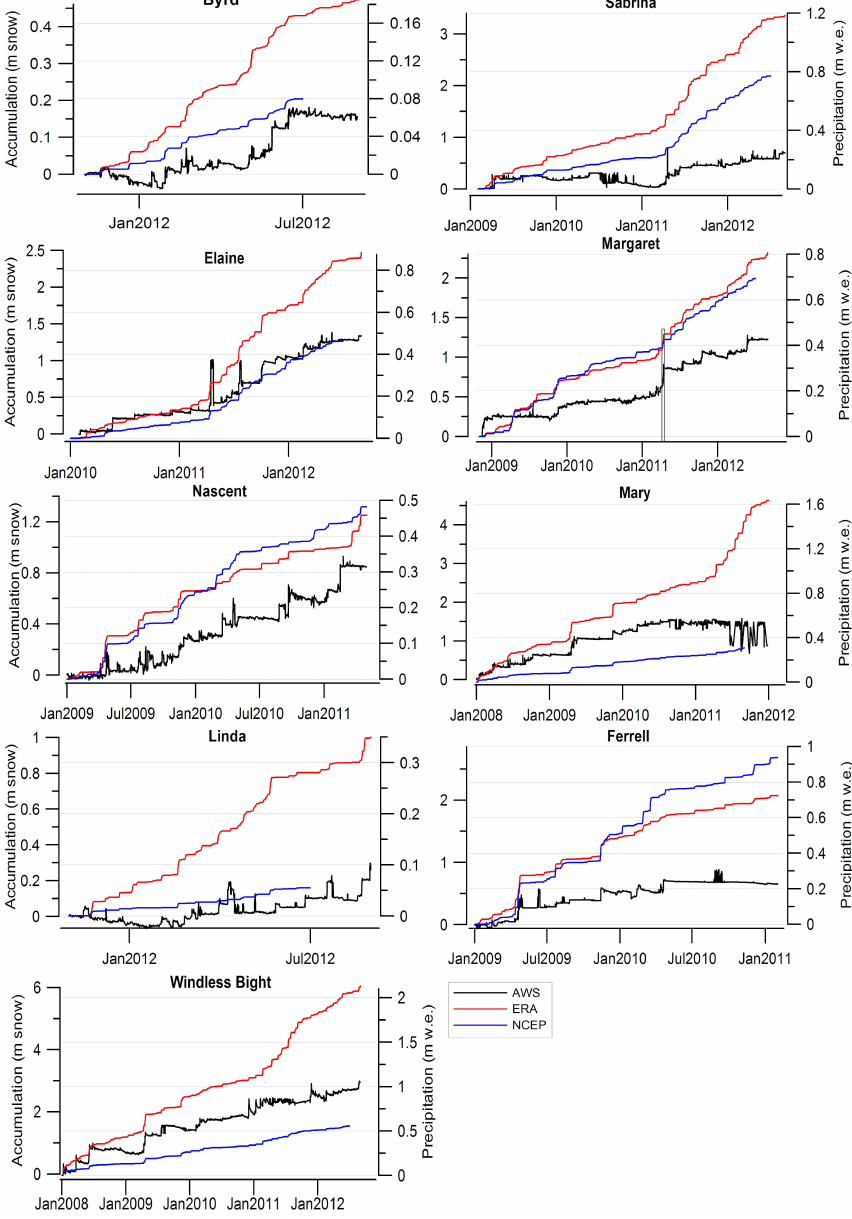
Fig. 2. Total accumulation and precipitation over time for each station (note different time periods). ADG accumulation is inm snow (left- hand axes) and ERA and NCEP reanalyses is in mw.e. (right-hand axes), with axes offset by 35% (approximate density of surface snow on RIS). A close up of the time period outlined by the grey box in the Margaret plot is shown in Fig. 4.